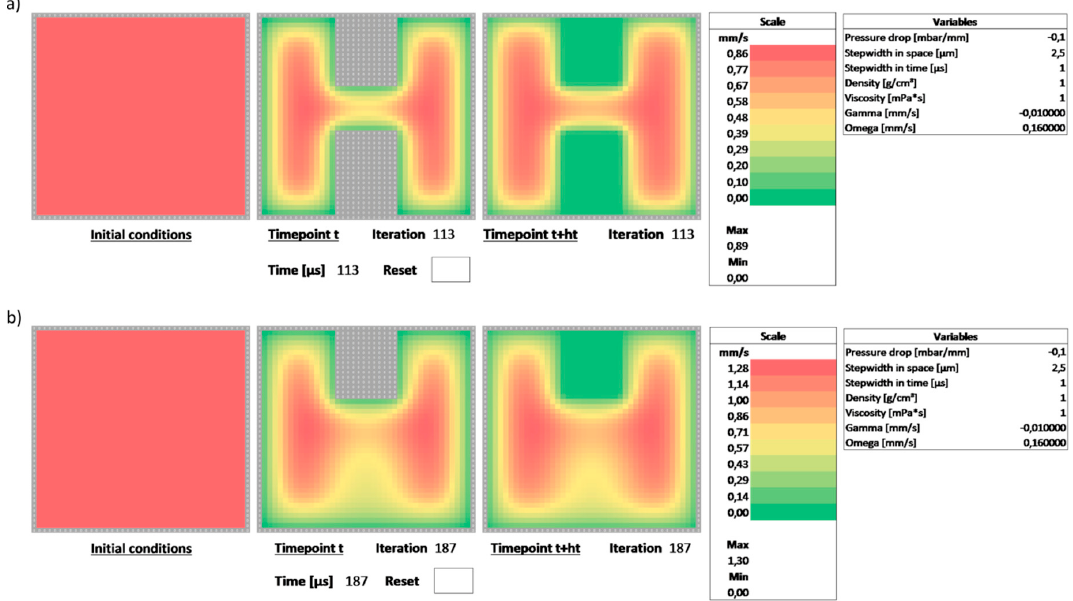
Figure 4. Complex flow cases involving intricate domains such as a double-constricted channel cross-section. ( a ) These are implemented by adding additional boundary values, i.e., by copying the grey cell values which have static values. The image shows the flow after around 100 iterations. ( b ) By simple overwriting portions of the boundary values with domain values, i.e., reimplementing the conditional copy operation of the center values, one of the obstacles is removed at a given point in time. The scheme can then be iterated to see how the flow adapts to the changes in boundary conditions. These can be implemented by copying additional boundary values into the center panel. By